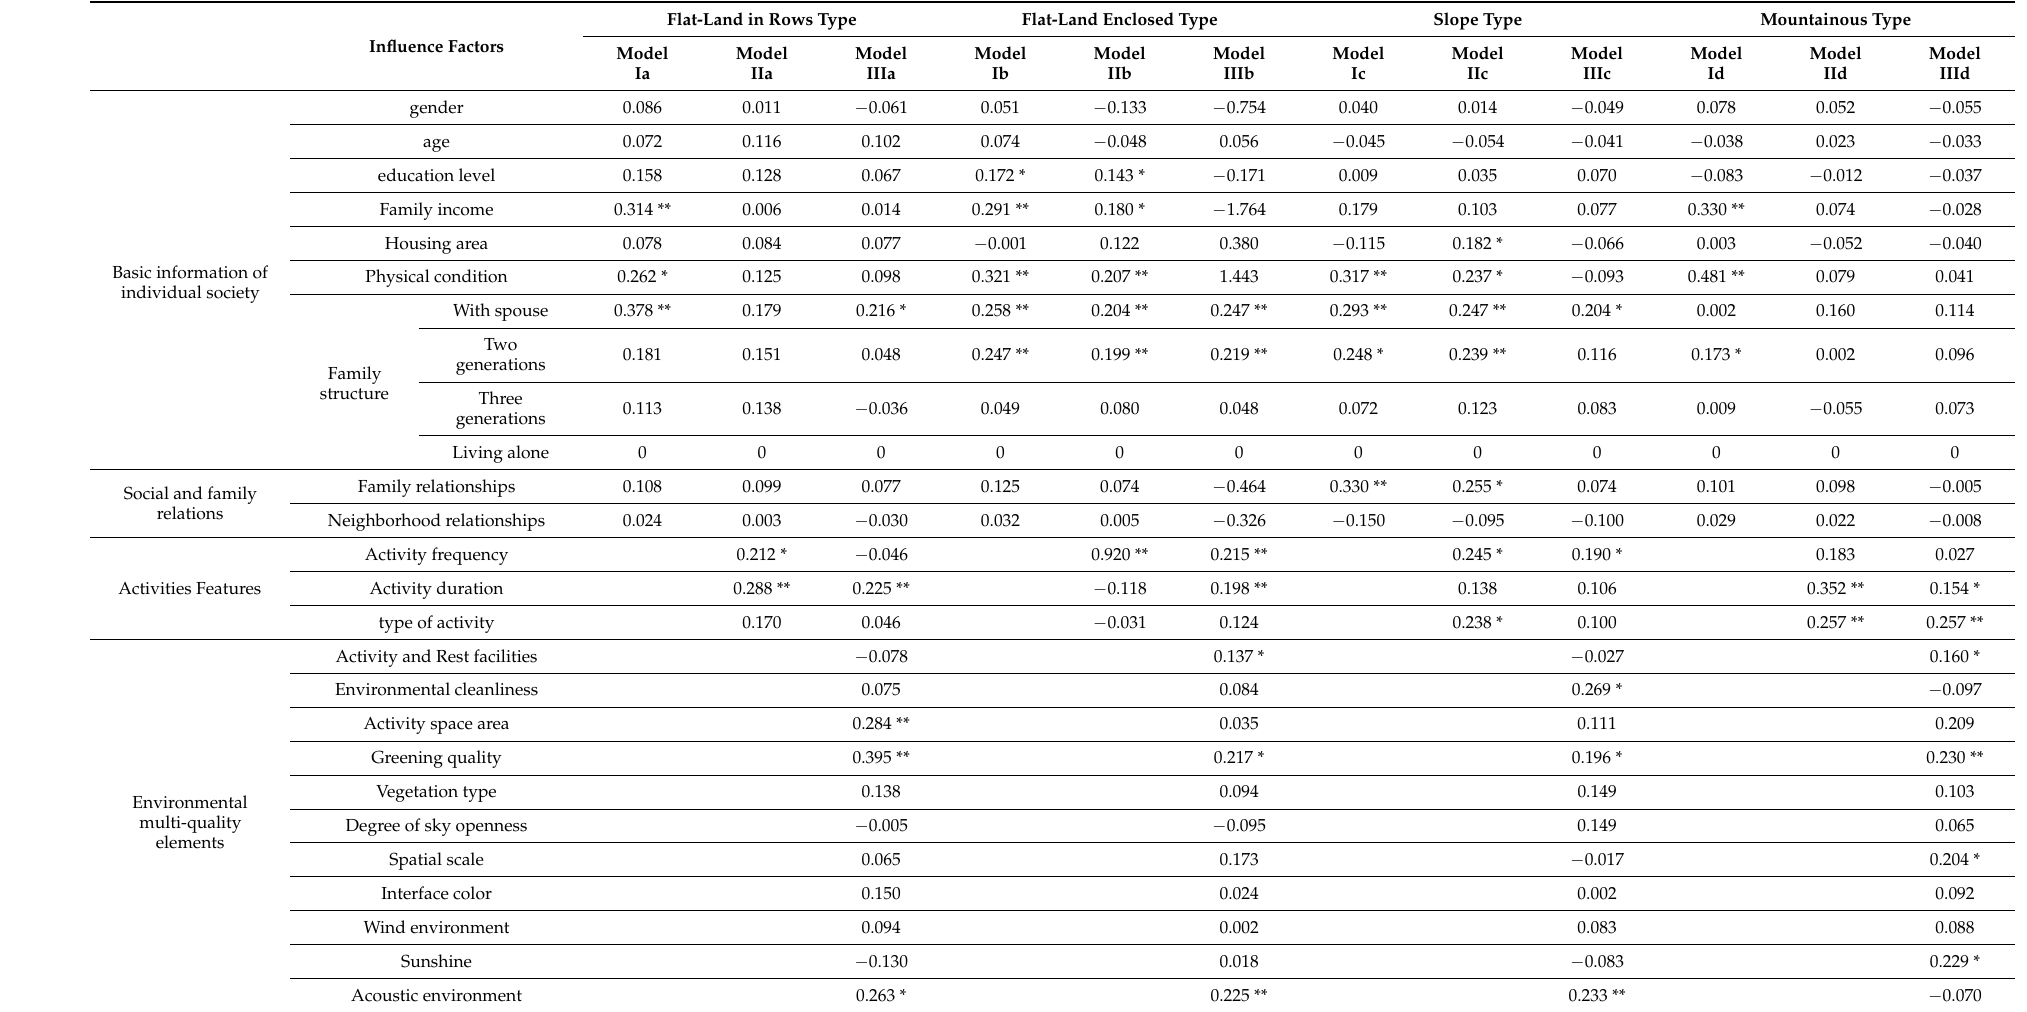
Table 7. Multi-factor hierarchical regression analysis of the same type of residential